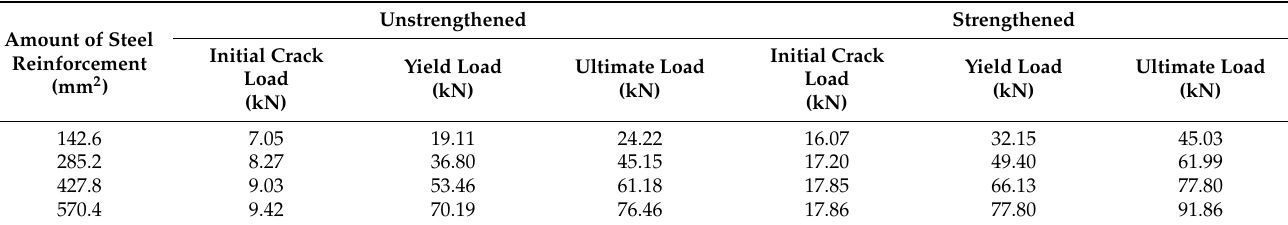
Table 2. Summary of numerical results for varying amounts of steel